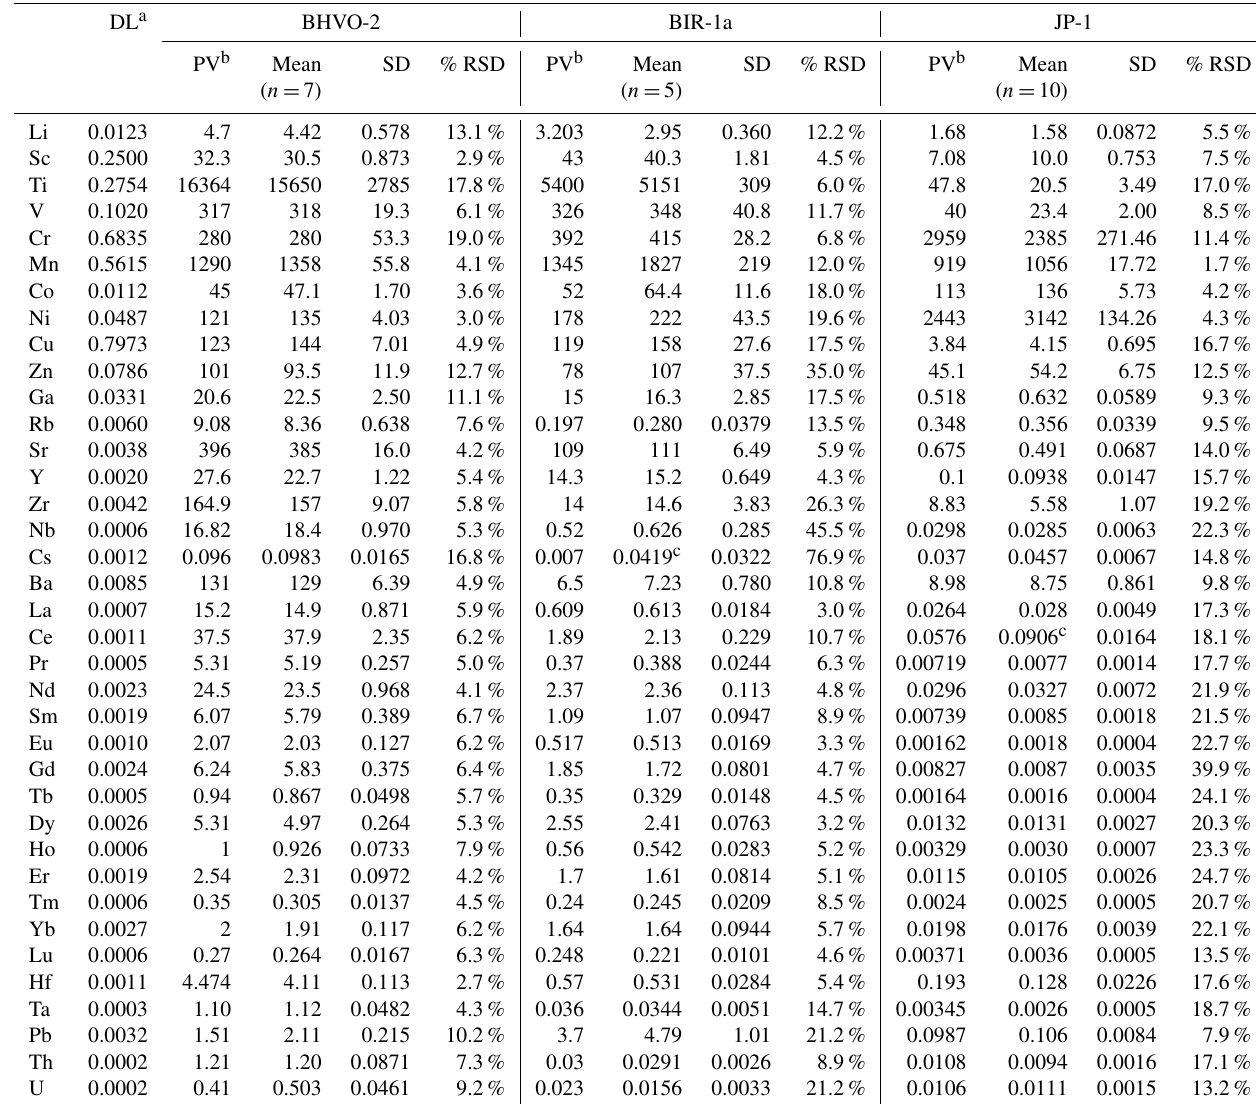
Table 2. Trace element concentrations (µgg − 1 ) for BHVO-2, BIR-1a and JP-1 determined by LA-ICP-MS analyses of pressed powder pellets on-board the D/V Chikyu